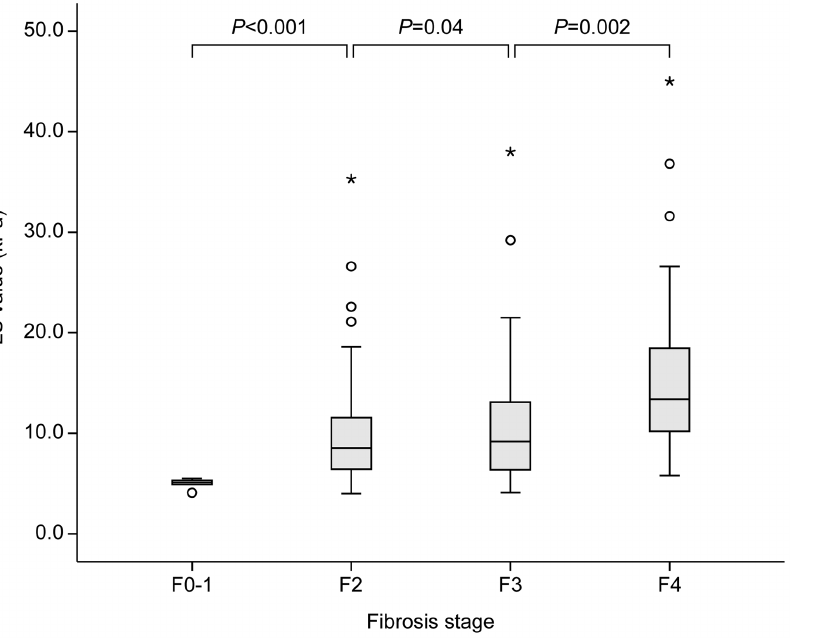
Figure 2. Distribution of LS values according to fibrosis stage. The median LS value increased significantly with fibrosis stage (P , 0.001). LS, liver stiffness.